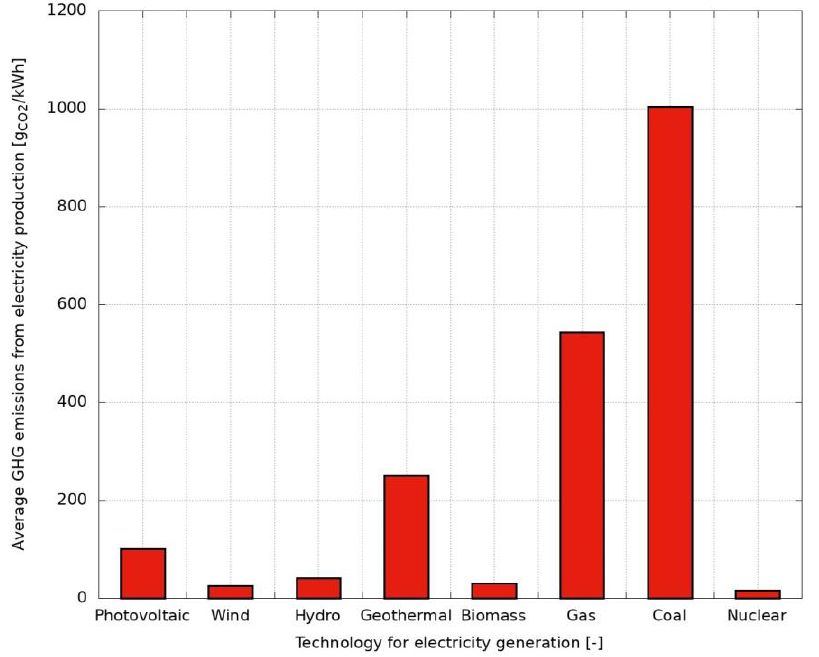
Figure 16. Average GHG emissions from electricity generation (own analysis from [28]).